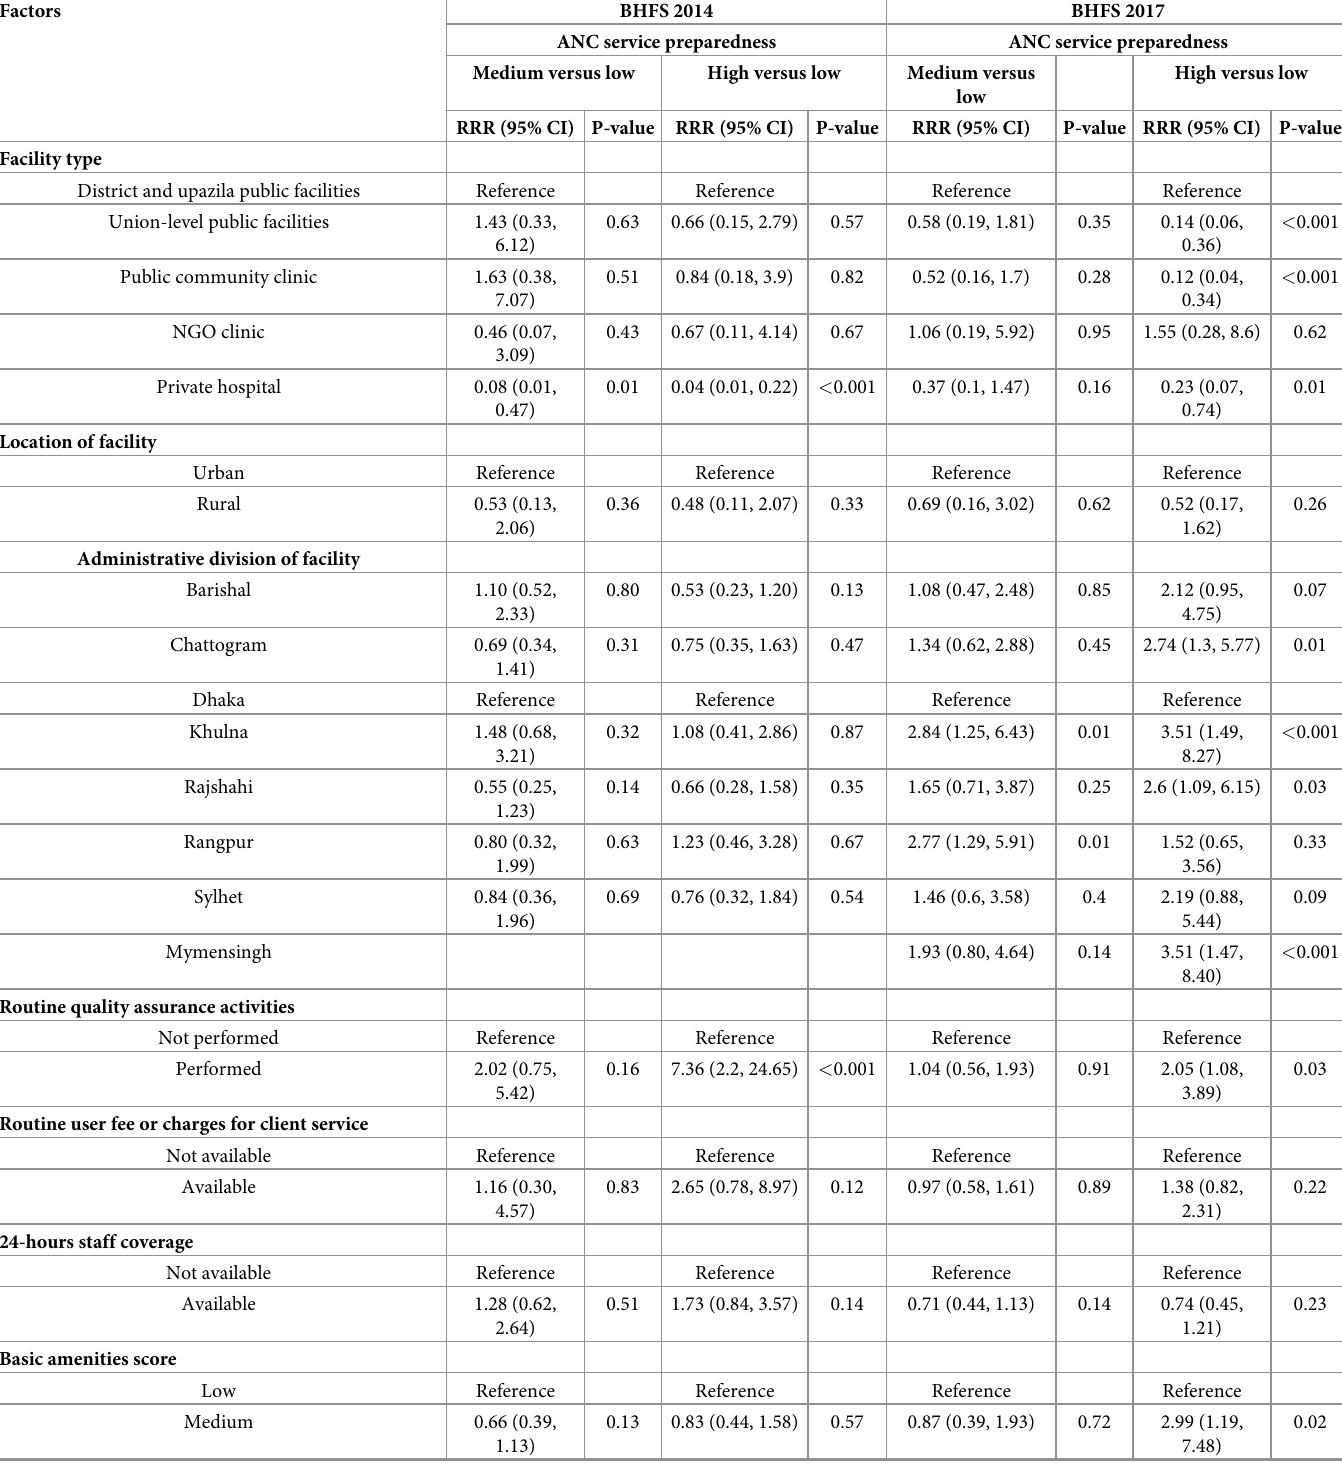
Table 4. Factors associated with ANC service preparedness: Relative risk ratio (RRR), 95% confidence intervals (CI), and P-values from adjusted multinomial logis- tic regression model by the survey